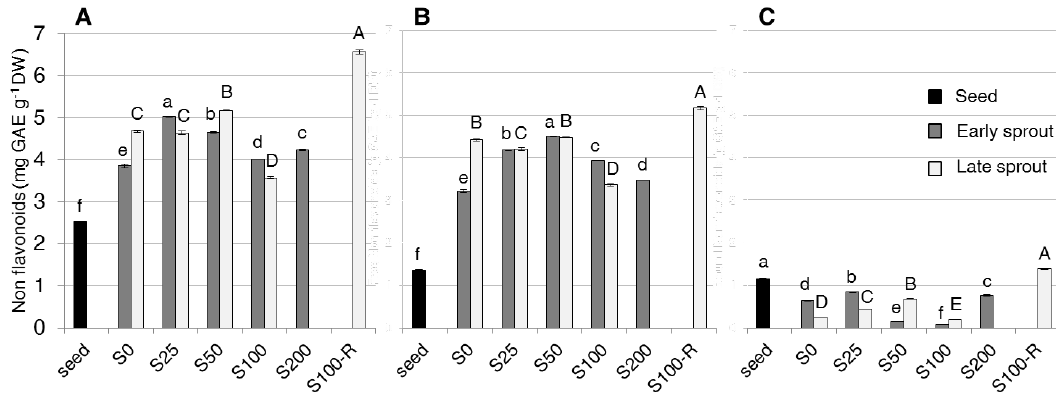
Figure 2. Total ( A ), free ( B ) and bound ( C ) non-flavonoid (NF) content (mg GAE g −1 DW) in seeds, early and late sprouts of rapeseed sprouted and grown with salt (NaCl) concentration 0, 25, 50, 100, 200 mM (S0, S25, S50, S100, S200, respectively) or sprouted with 100 mM and then grown with distilled water as recovery treatment (S100-R). Average values of duplicate determinations ± standard error are depicted. Different letters within each graph indicate statistically significant differences at p = 0.05 (Fisher’s LSD). Lower case letters are for comparison within early sprouts; upper case letters for comparison within late sprouts.